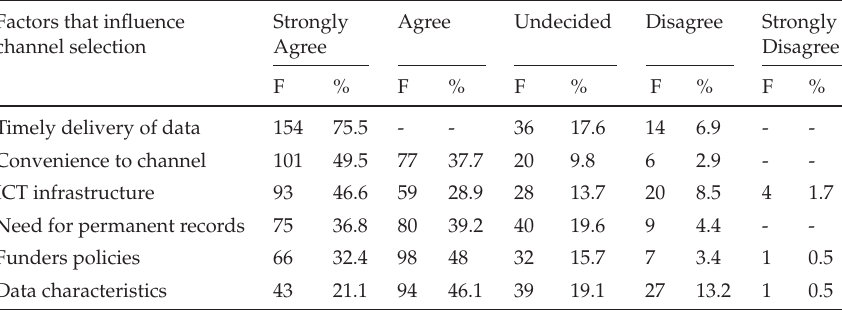
Table 3: Factors that influenced researchers in channel selection (n = 204). Factors that influence channel